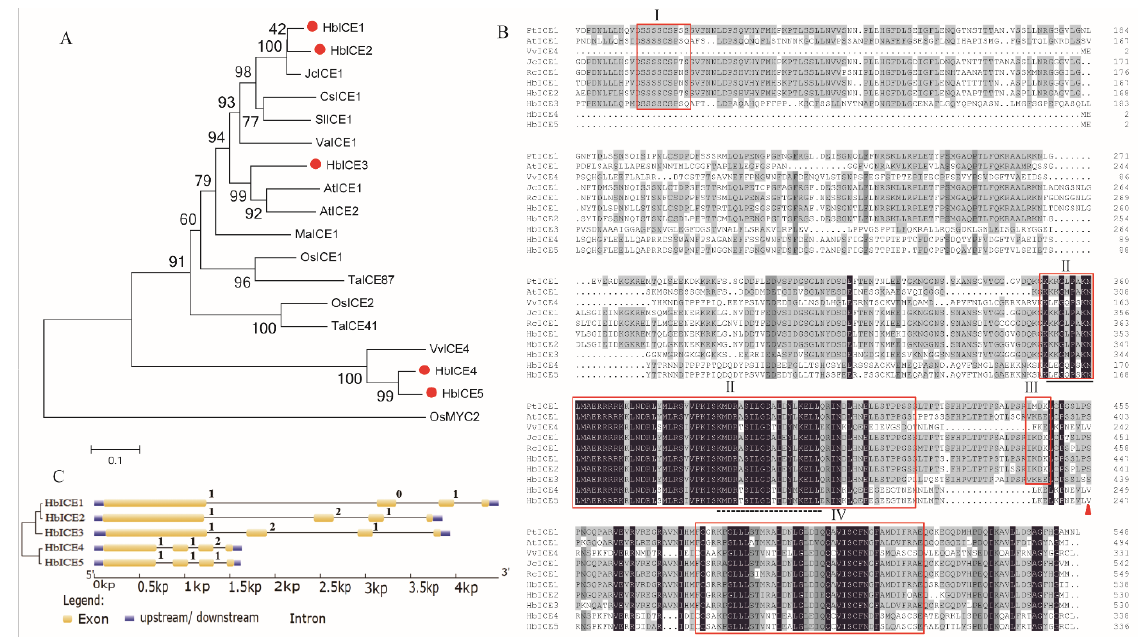
Figure 1. Phylogenetic tree, alignment, and gene structure of five HbICEs. Phylogenetic tree was constructed according to the deduced amino acid sequences through MEGA5.10 program ( A ). Gen- Bank accession numbers listed in parentheses: rubber tree (HbICE1, KY406162; HbICE2, KY406163; HbICE3, KY406164; HbICE4, KY406165; HbICE5, KY406166), rice (OsICE1, XP_015616517; OsICE2, KAF2954112; OsMYC2, XP_015614012), Arabidopsis (AtICE1, AT3G26744; AtICE2, AT1G12860), Populus trichocarpa (PtICE1, XP_002318166), Camellia sinensis (CsICE1, ACT90640), Solanum lycop- ersicum (SlICE2, AGG38826), Triticum aestivum (TaICE41, ACB69501; TaICE87, ACB69502), Vitis vinifera (VvICE1, AGP04217; VvICE4, AHM24956), and Jatropha curcas (JcICE1, NP_001306859). Multiple alignment of the deduced amino sequence of HbICEs with typical ICE proteins from other plants ( B ). Identical and similar residues are shaded black and gray, respectively. The conserved fragments, such as S-rich region (box I), bHLH-ZIP domain (box II), the putative SUMO conjugation motif (box III), and ACT-like domain (box IV), are specifically found in ICE proteins and asterisks indicate serine, a key residue for the protein stabilization of ICEs. The black line below the sequence represents the nuclear localization signal (NLS). The dotted line indicates a conserved region of ICEs. The origin and GenBank accession numbers are as follows: Vitis vinifera (VvICE4,